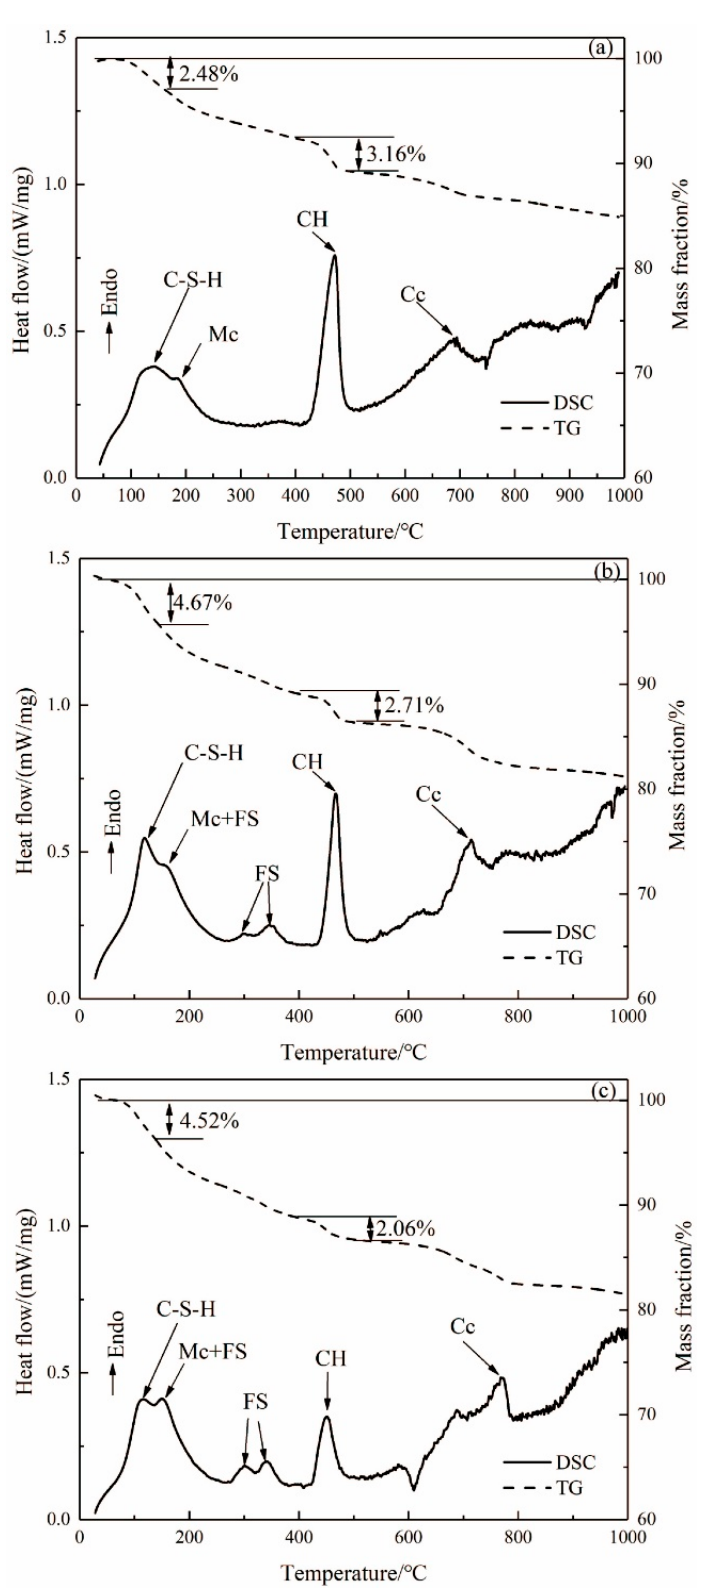
Figure 4. DSC and TG curves of ( a ) OPC paste, ( b ) ASR-10 paste, and ( c ) ASR-20 paste (Mc: mono- carbonate; FS: Friedel’s salt; CH: Ca(OH) 2 ; Cc: CaCO 3 ).